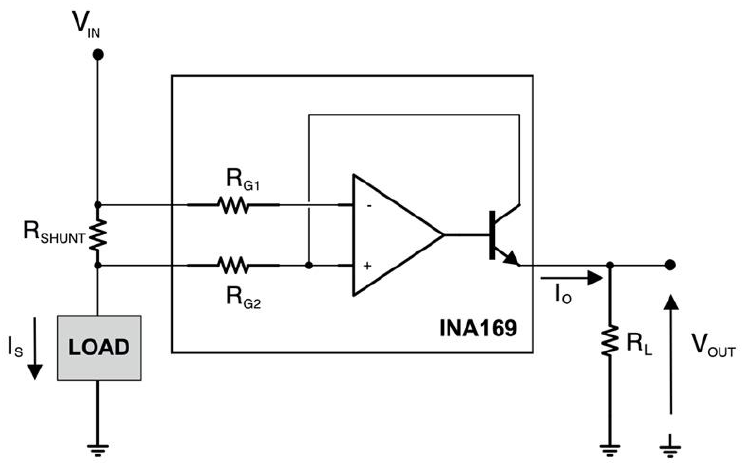
Figure 7. Current measurement circuit based on INA169. V IN = 7.4 V; R SHUNT = 0.1 Ω; R L = 9.35 KΩ; R G1 = R G2 = 1 KΩ.